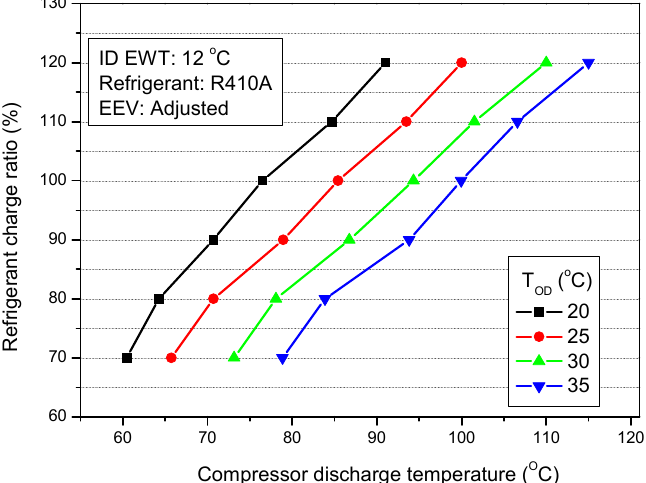
Figure 22. Relationship between the refrigerant charge ratio and compressor discharge temperature in cooling mode.